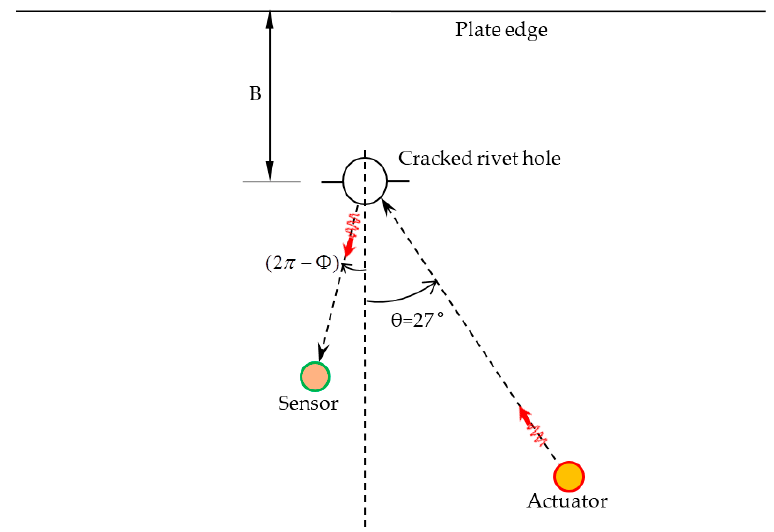
Figure 11. A simplified case of the multiple-rivet-hole problem.